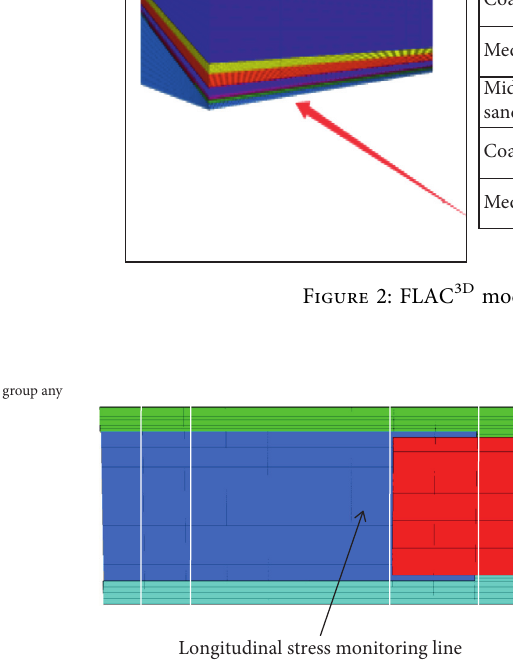
Figure 3: Monitoring lines of the third left mining face.